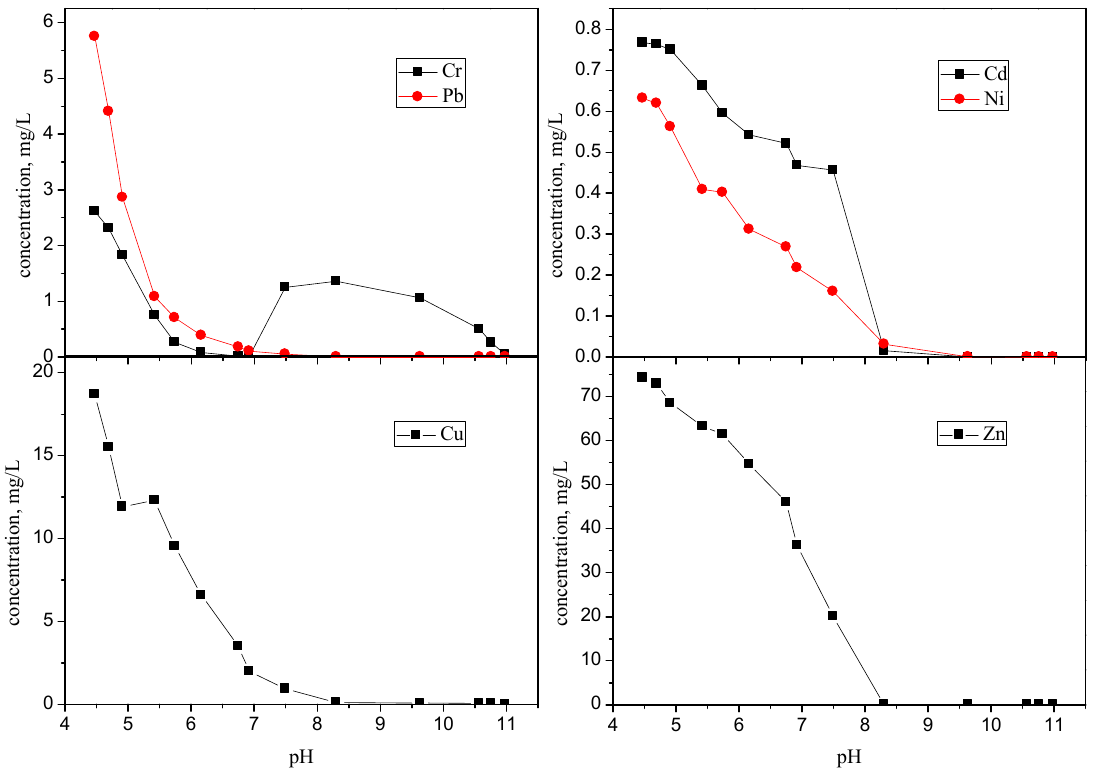
Figure 6. Evolution of leaching concentration of heavy metals vs. pH for raw fly ash.